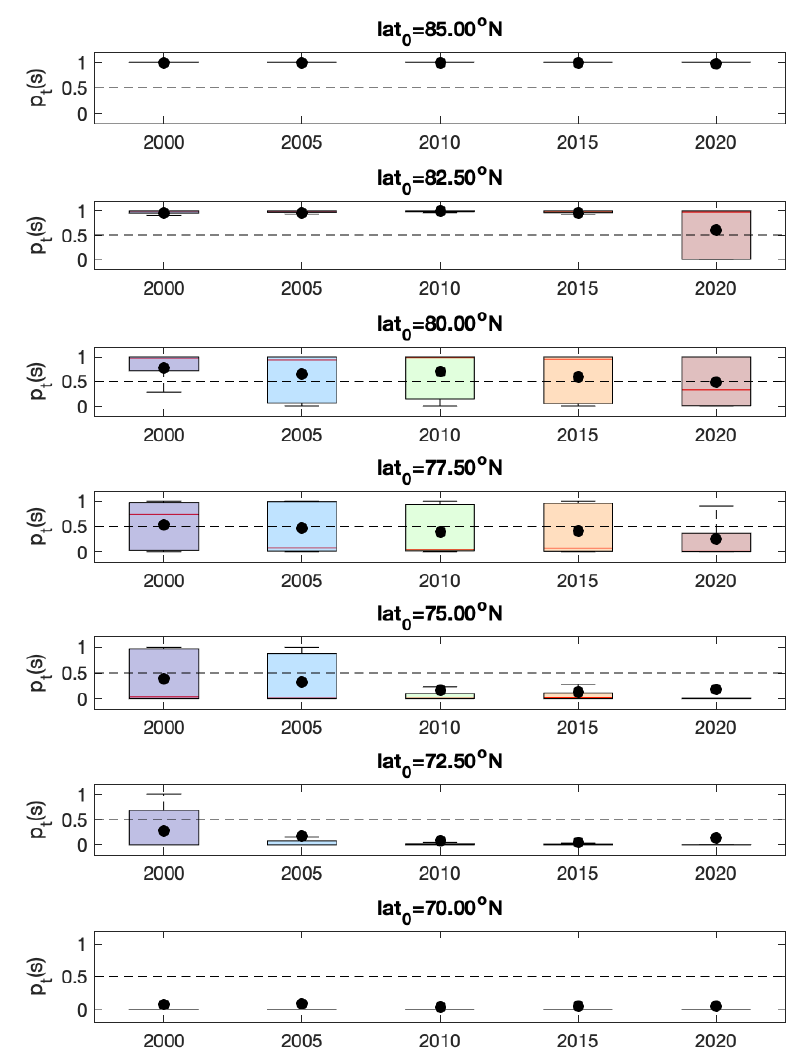
Figure 10. Boxplots of the estimates { ˆ p t ( s i | y t − 1 ) : i = 1, . . . , N } from the model given by (3) for different latitude bands with half-bandwidth δ = 0.5 ◦ . The horizontal dashed line indicates a 0.5 probability, and the solid dots indicate the averaged values of { ˆ p t ( s i | y t − 1 ) : i = 1, . . . , N } . The horizontal bars in the boxplots show the five-number summaries of a distribution (namely, minimum, first quartile, median, third quartile, and maximum). The five-year-interval boxplots are shaded from blue (2000) through green (2010) to red